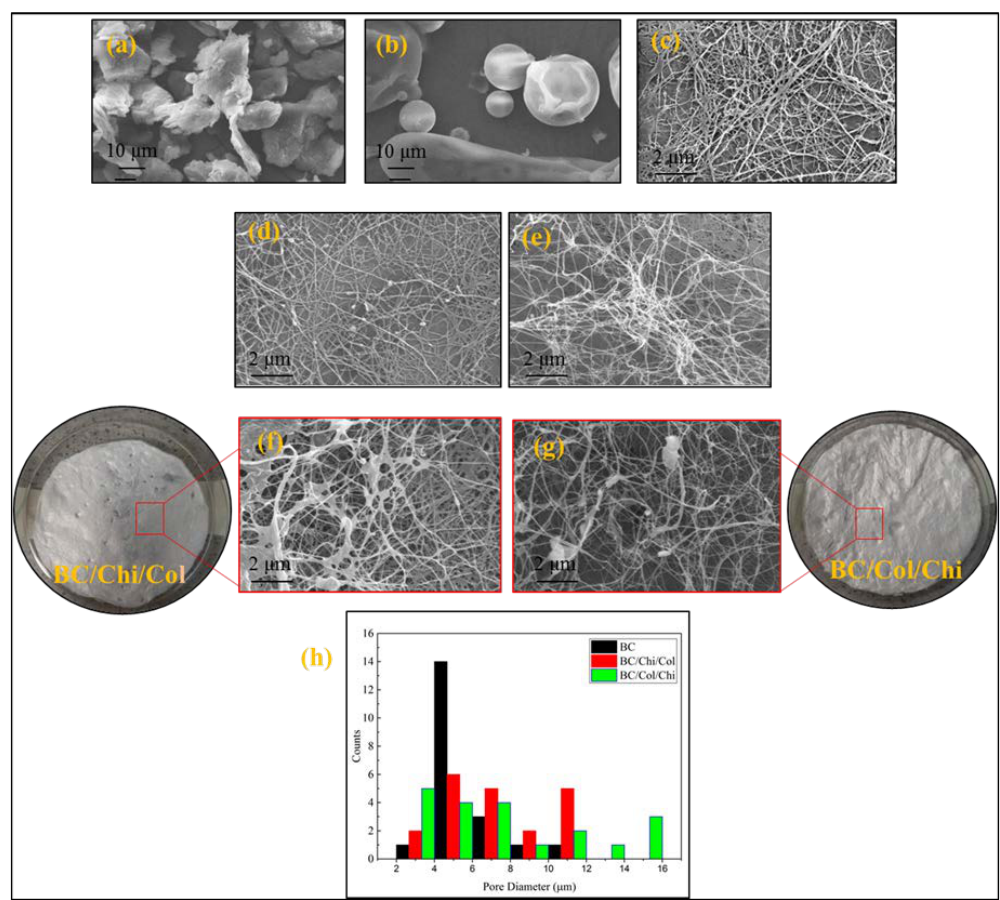
Figure 6. SEM photographs of ( a ) pure chitosan powder, ( b ) pure collagen powder, ( c ) lyophilized pure BC fiber, ( d ) lyophilized BC / Chi mats, ( e ) lyophilized BC / Col mats, ( f ) lyophilized BC / Chi / Col mats, ( g ) lyophilized BC / Col / Chi mats, and ( h ) pore diameter